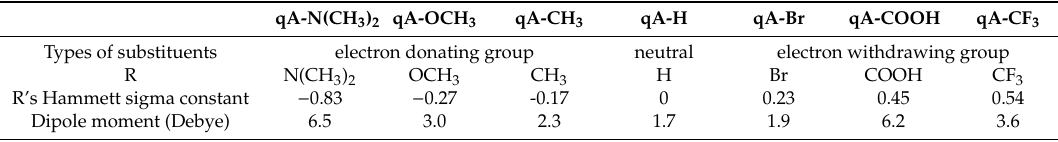
Table 5. The values of Hammett sigma constants of various substituents [35] and magnitudes of molecule’s dipole